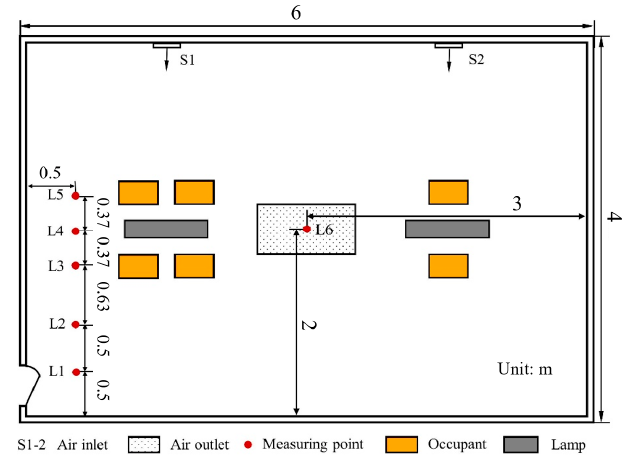
Figure 2. Layout of the measurement points. Table 1. Details of the measurement instruments.